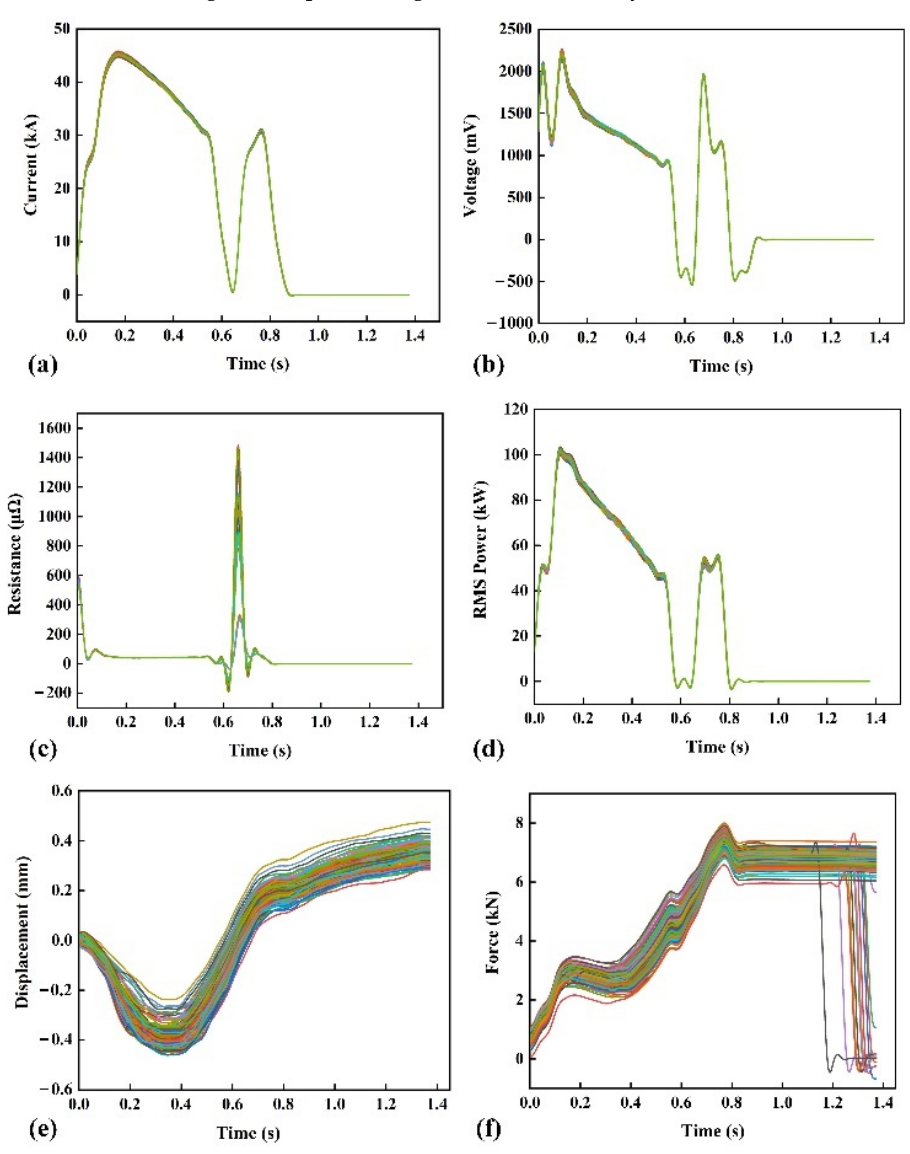
Figure 3. Preprocessed partial welding process signal: ( a ) current; ( b ) voltage; ( c ) dynamic resistance; ( d ) RMS power; ( e ) electrode displacement; ( f ) electrode force.